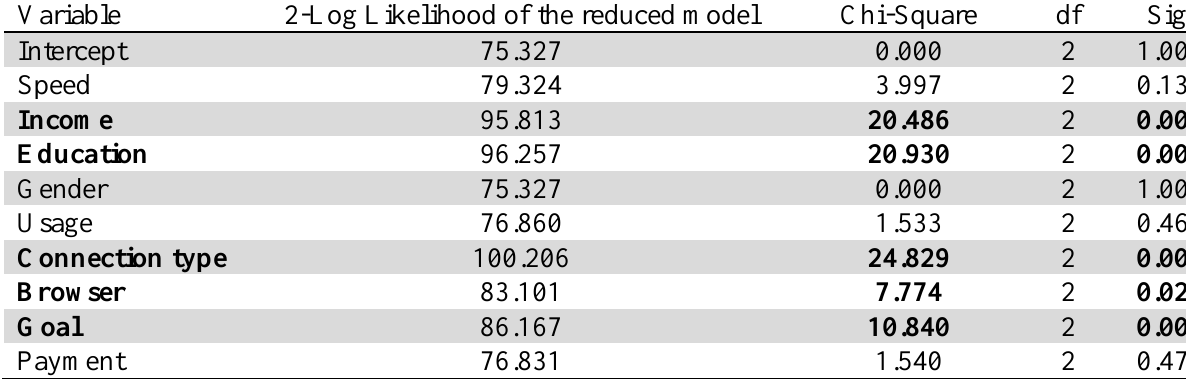
The summary of Likelihood ratio test for different factors on consumers’ behavior